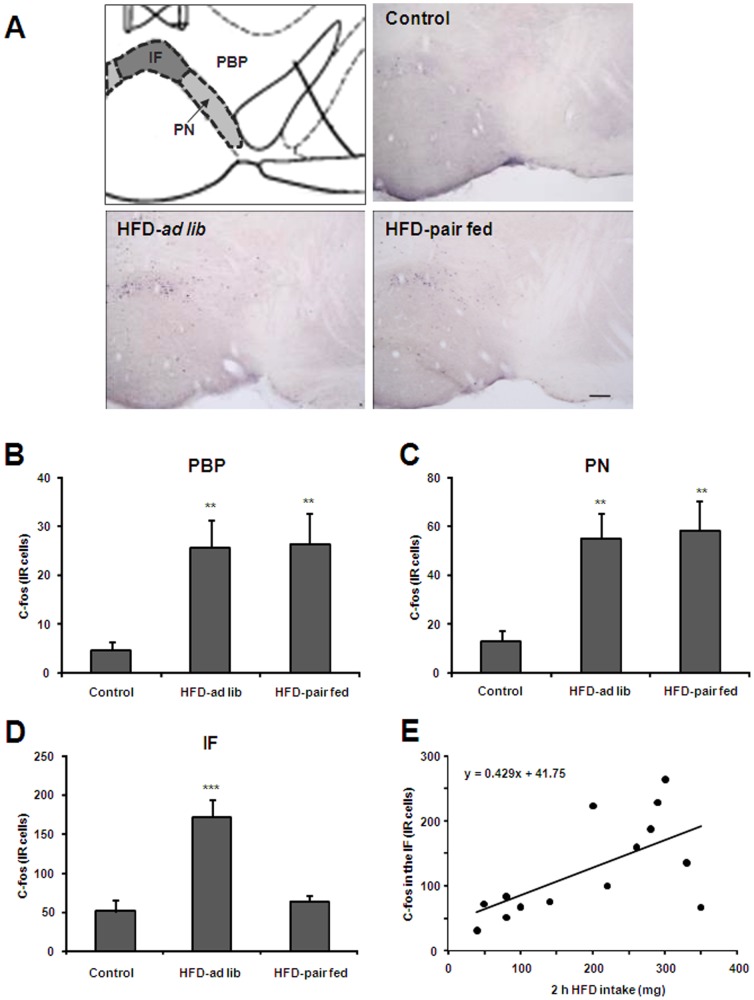
Acute HFD activates c-Fos in specific sub-regions of the VTA.Panel A shows a schematic diagram of VTA sub-regions in a coronal section of the mouse brain (upper left) and representative microphotographs of c-Fos (black/purple signal) immuno-staining in the VTA of control (upper right), HFD-ad lib (bottom left) and HFD-pair-fed (bottom right) groups. Scale bar: 100 µm. Panels B-D show quantitative analysis of c-Fos staining in specific PBP (B), PN (C) and IF (D) sub-regions of the VTA. Histograms depict the total number of c-Fos-IR neurons, expressed as cells per coronal section, for each experimental group. Values are the mean±SEM. **, p<0.01 vs. control group. ***, p<0.001 vs. control group. Panel E shows the correlation between 2 h food intake and c-Fos-IR cells in the IF sub-region of the VTA in HFD-ad lib group (r = 0.628). Each point represents a measurement from a single animal.